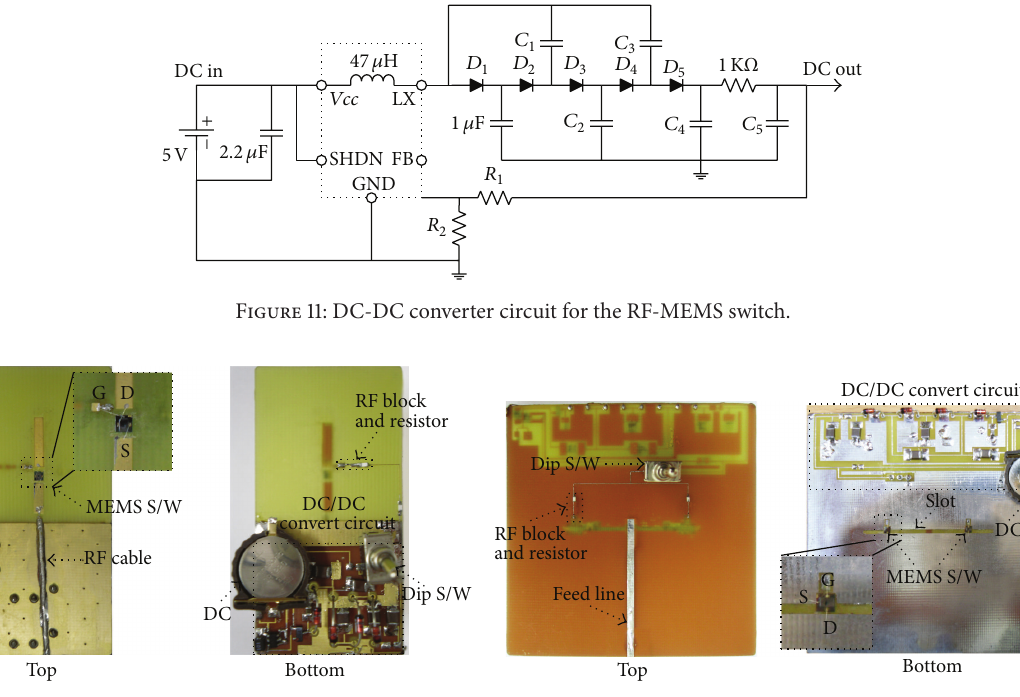
the reconfigurable slot with the MEMS switch was narrower than that of the diodes in the ON-state , 130 MHz